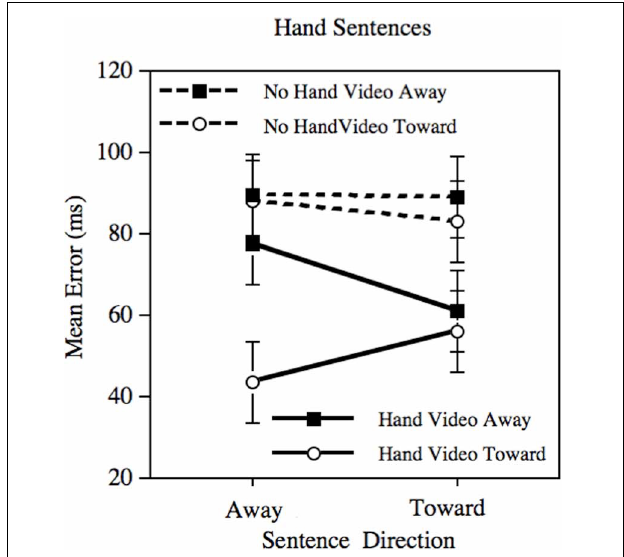
FIGURE 1 | Mean error in prediction following adaptation using the Hand sentences. Error bars depict the standard error of the mean.